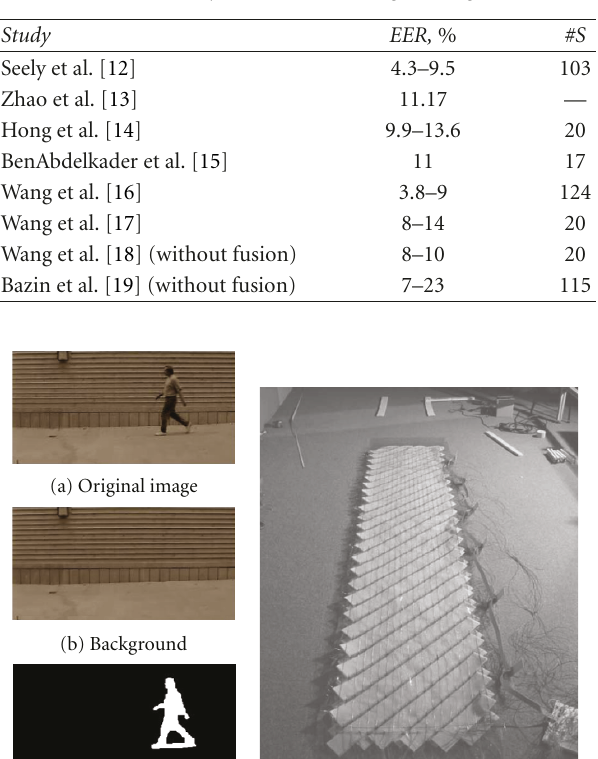
Table 2: Summary of several FS-based gait